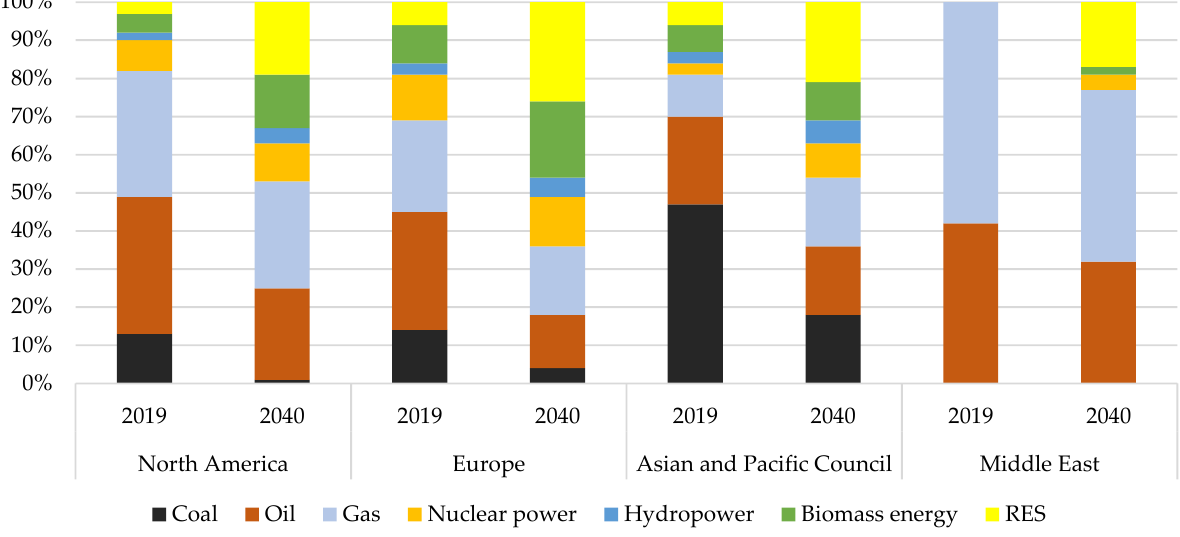
Figure 5. Energy consumption in world regions by energy source (based on [1]).